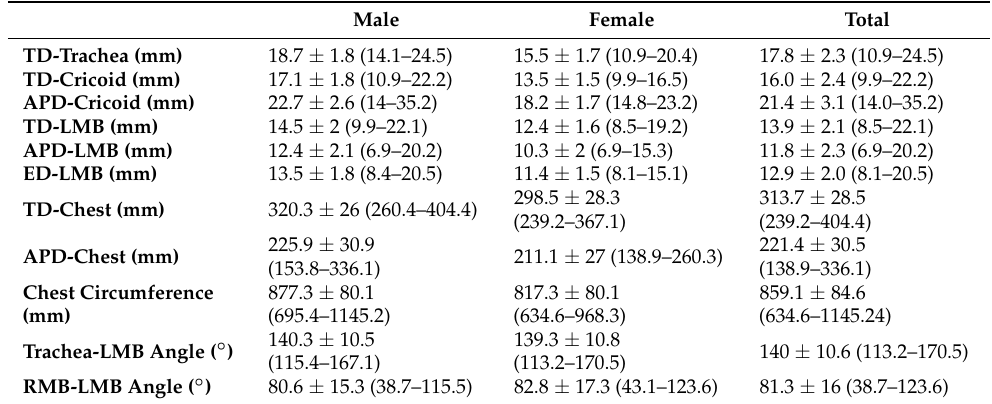
Table 4. Roentgenogram Measurements. Values are given as mean ± standard deviation (minimu- m–maximum).